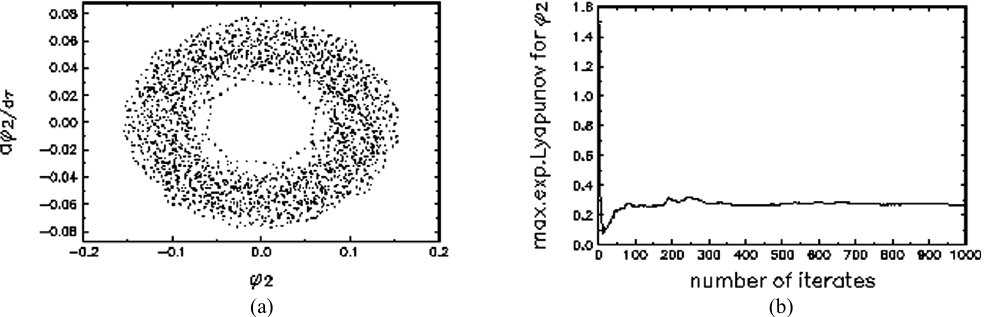
Fig. 13. Poincaré map (a) and Lyapunov exponents (b) of ϕ 2 for γ 4 = 0 and for: a 1 = a 2 = 0.1; a 3 = 0.0001; γ 1 = 0.0001; γ 2 = γ 3 = 0; β 1 = 0.65; c = 1; u 1 = u 2 = 1.5; q =